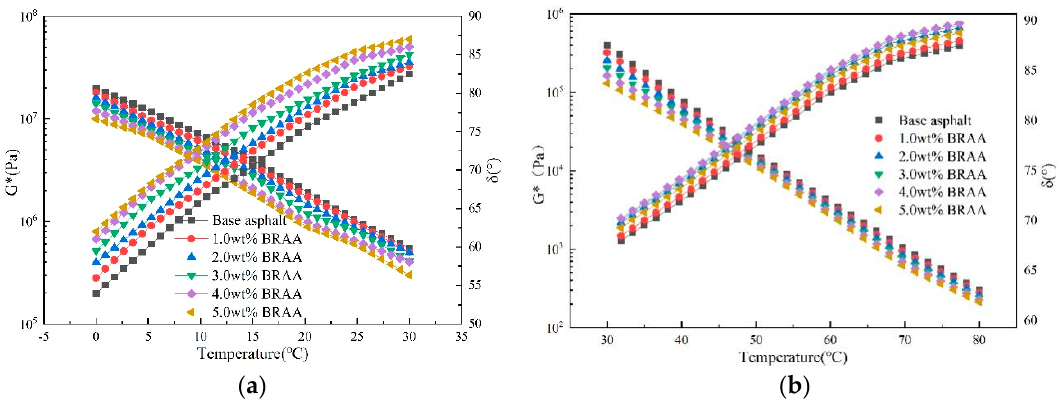
Figure 8. DSR test results: ( a ) low temperature = 0–30 °C, ( b ) high temperature = 30–80 °C.